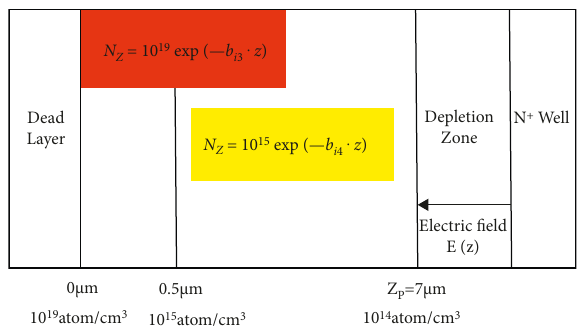
Figure 9: Electron multiplication layer multisegment exponential doping structure model 2.